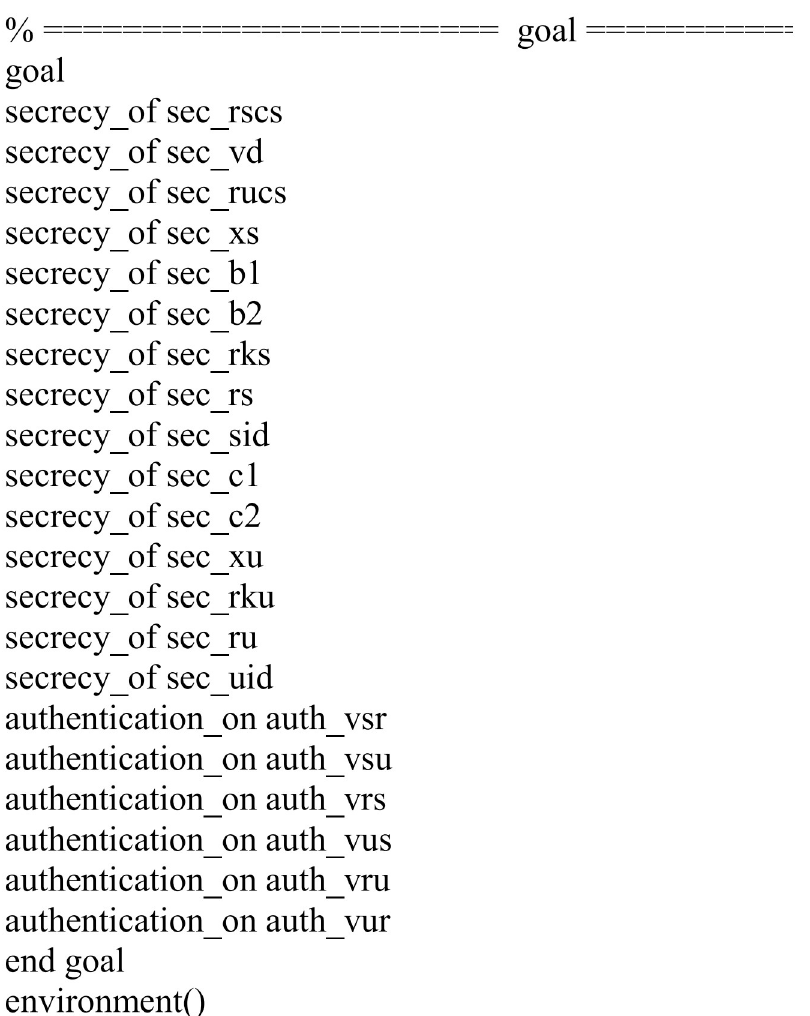
Fig 9. Role specification in HLPSL for the